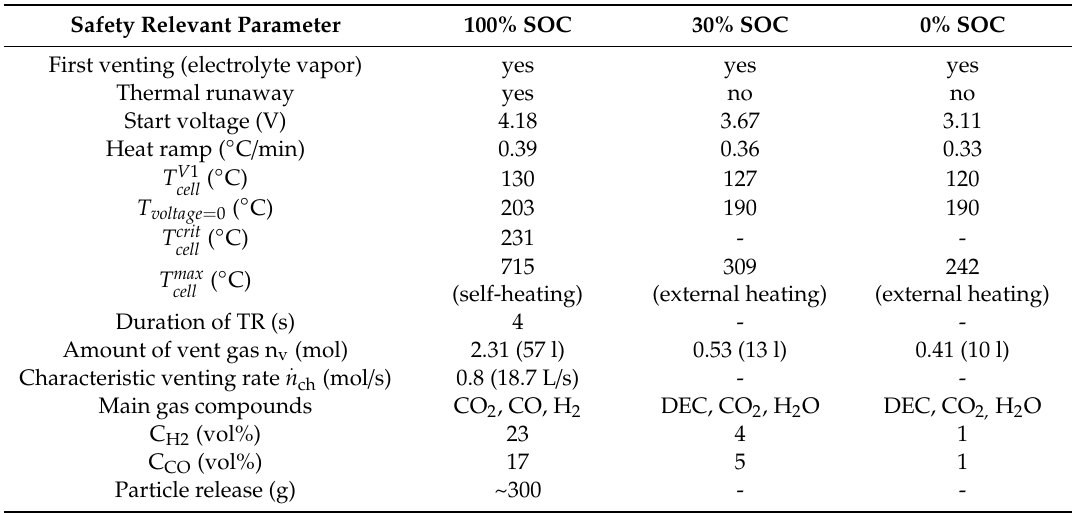
Table 5. Summary of safety relevant parameters of overtemperature experiment of the fresh automotive pouch cell at 100%, 30% and 0% SOC.